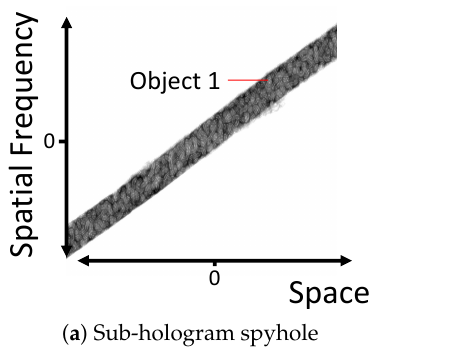
Figure 13. ( a , b ) show the phase space footprints of the spyhole (Object 1) and the dice (Object 2) sub-holograms extracted with [30] from Figure 8c. Note, in ( b ) only the rims of the spyhole occlude the dice in this part of phase